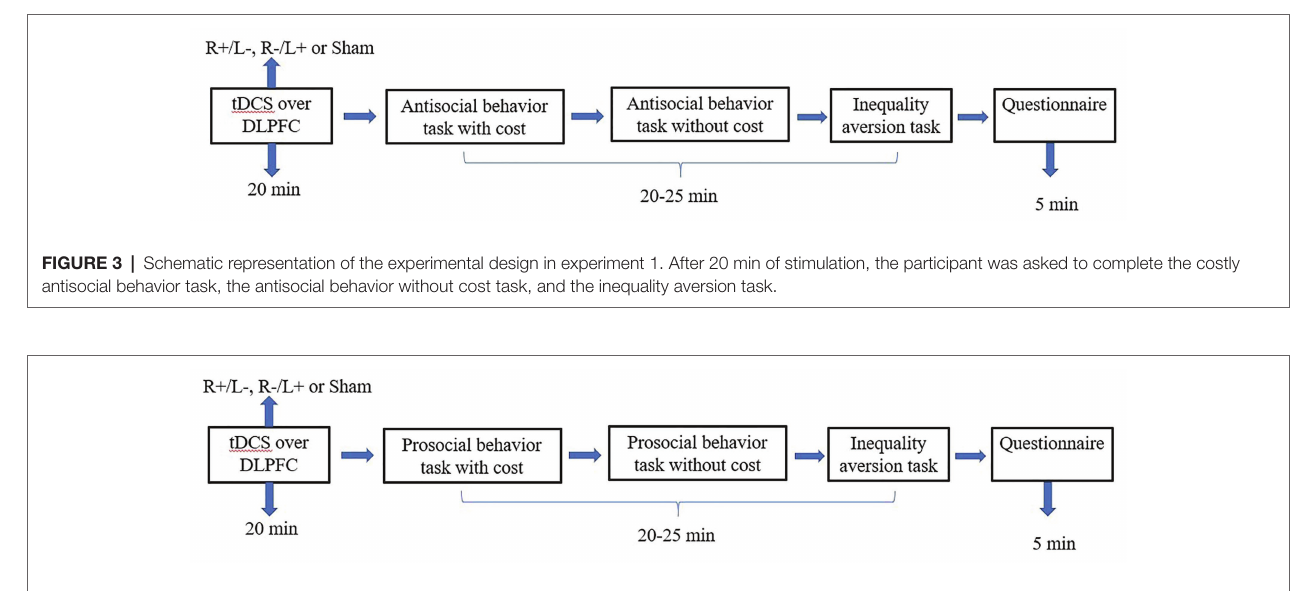
FIGURE 4 | Schematic representation of the experimental design in experiment 2. After 20 min of stimulation, the participant was asked to complete the costly prosocial behavior task, the prosocial behavior without cost task, and the inequality aversion